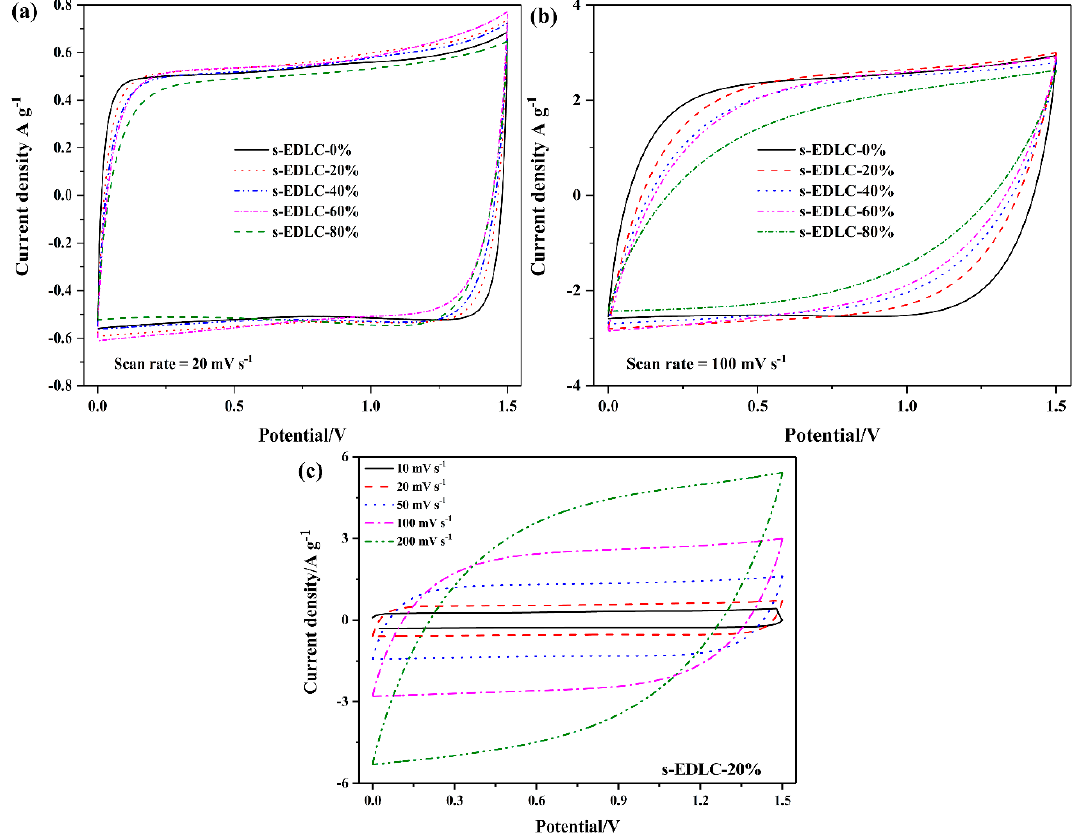
Figure 5. CV curves at a scan rate of 20 mV·s − 1 ( a ) and 100 mV·s − 1 ( b ) of the solid-state EDLCs and the CV curves of s-EDLC-20% at various scan rates (10–200 mV · s − 1 ) ( c ).